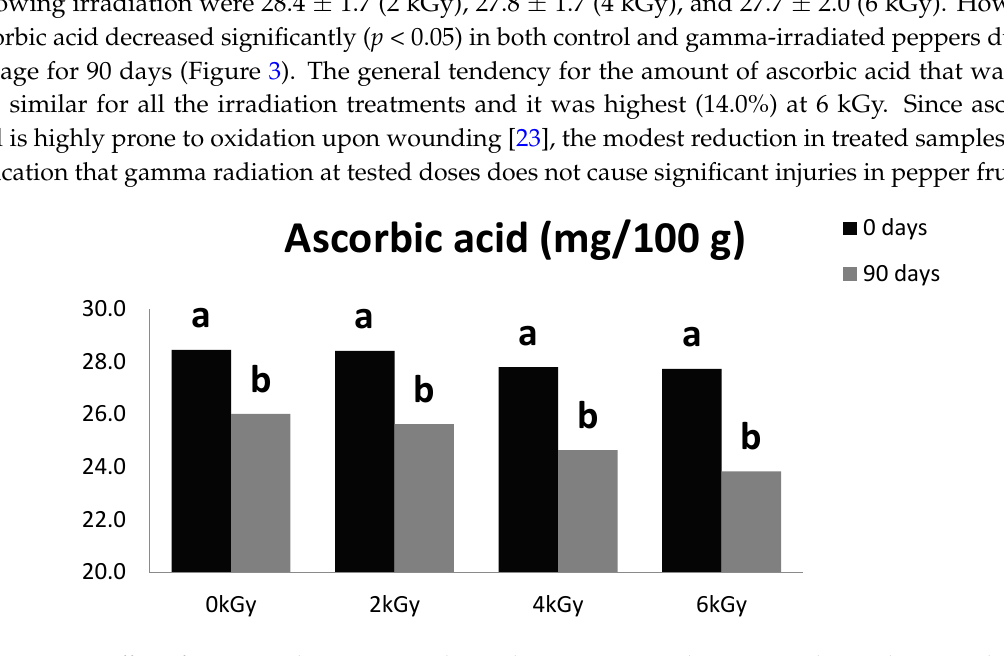
Figure 3. Effect of gamma radiation on ascorbic acid concentration in hot peppers during three months’ storage; a , b indicate differences between these pairs of treatment means at p < 0.05.